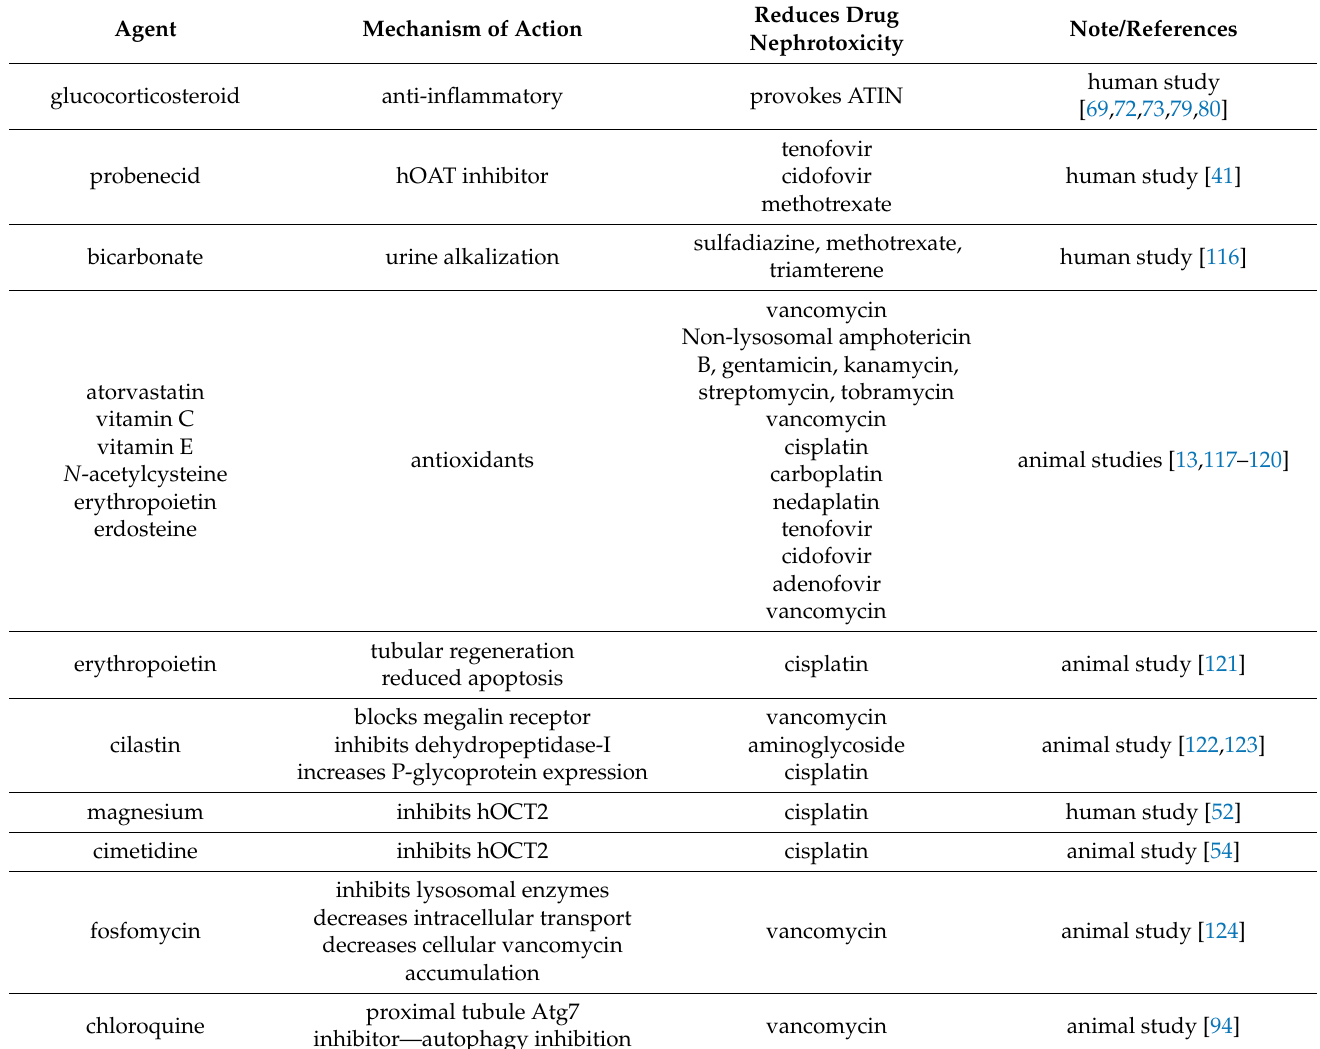
Table 3. Specific prevention and/or treatment for different nephrotoxic